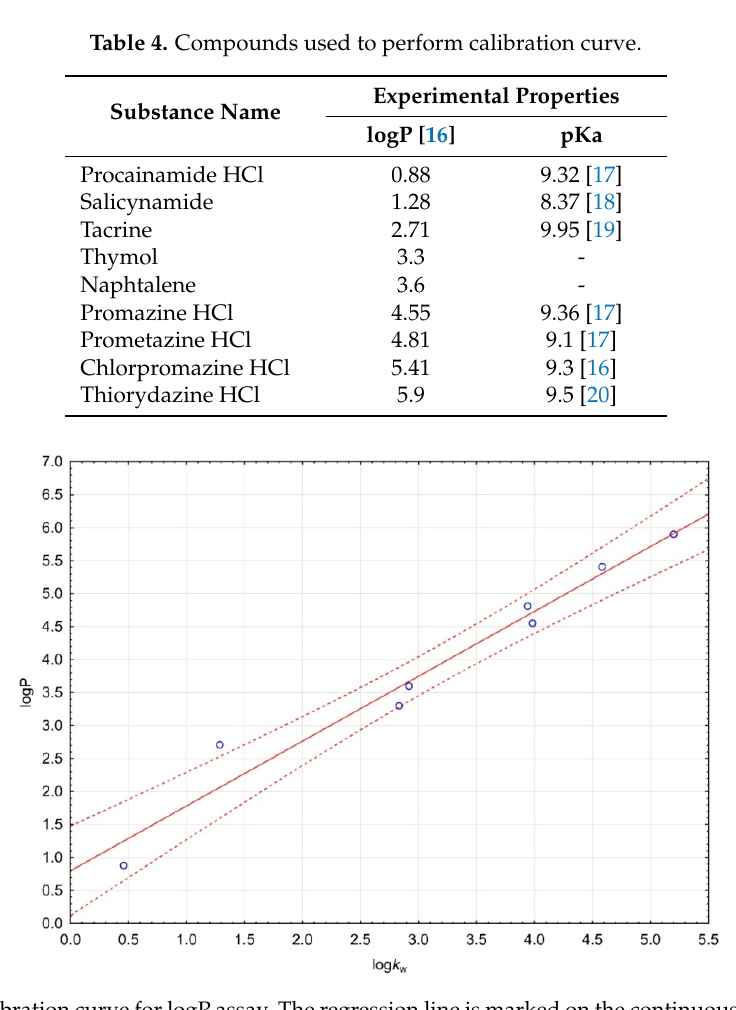
Table 4. Compounds used to perform calibration curve.